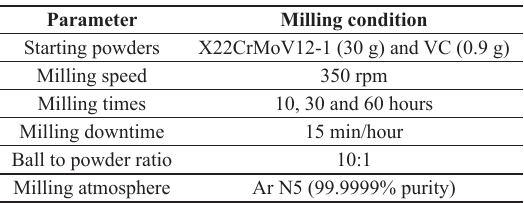
Table 1. X22CrMoV12-1 alloy milling